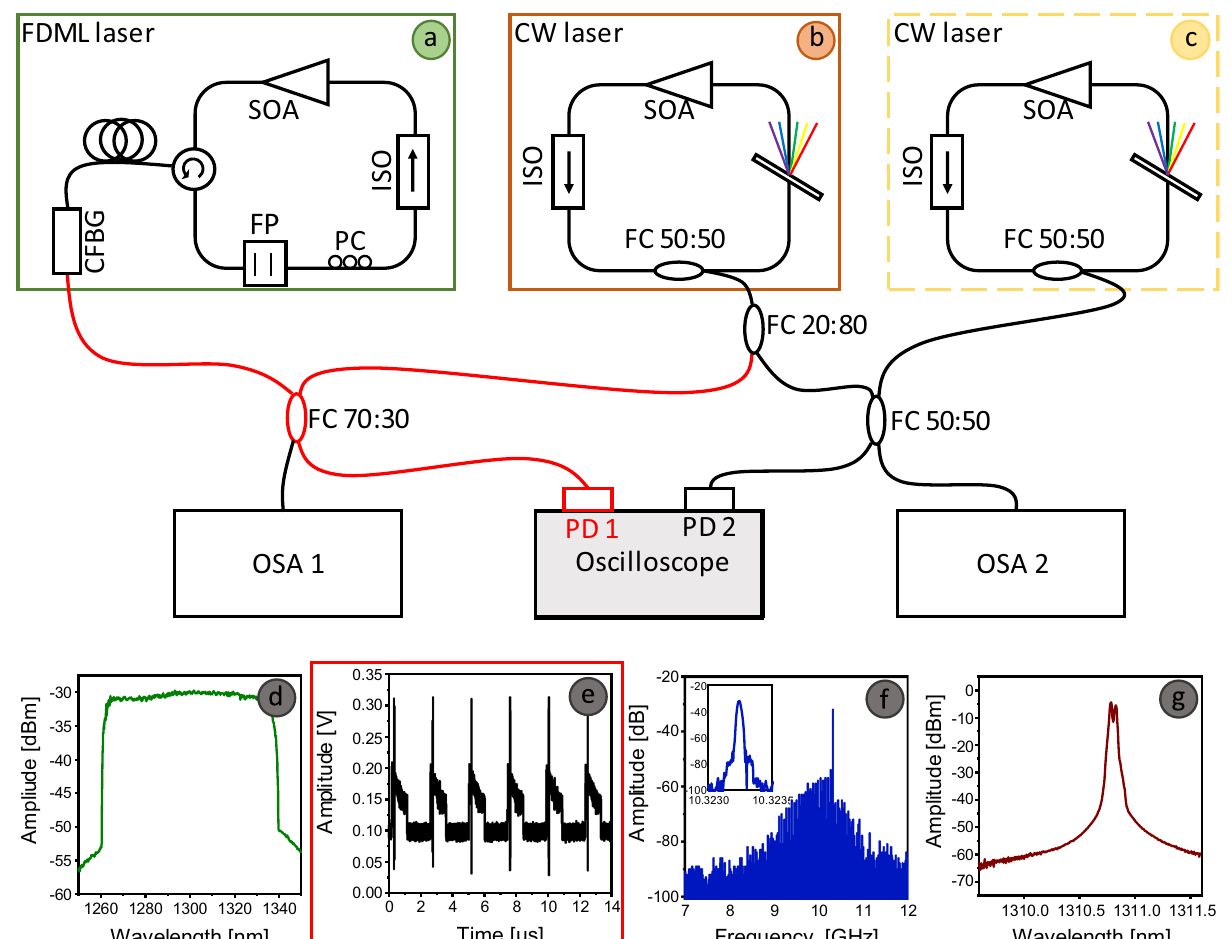
Fig. 1 Setup for beat signal measurements. The core of the investigation is the superposition of the temperature stabilized Fourier domain mode-locked (FDML) laser ( a ) and one continuous wave (CW) laser ( b ) as shown in red. An auxiliary CW laser ( c ) is superimposed with the fi rst one to simultaneously generate a second beat signal to monitor the short-term linewidth of the CW lasers. One optical spectrum analyser (OSA 1) is used to monitor the spectrum of the FDML laser ( d ). The transient beat signals between FDML laser and CW laser ( e ) are measured on a photodiode PD 1 and recorded with a fast real-time oscilloscope (shaded rectangle). The time trace of the second beat signal was measured on the second channel of the oscilloscope with a photodiode PD 2. A live Fourier transform was performed on the signal showing the radio frequency spectrum ( f ) to estimate an upper limit of the convoluted linewidth of both CW lasers. Only measurements for which this second monitoring signal shows a narrow linewidth were used for the analysis of the FDML laser, because only then we can assume that the CW laser had a suf fi ciently narrow linewidth to see fl uctuations on the FDMLlaser ’ s linewidth.For easytuning of the CWlasers to generate a certain desired beat frequency, their optical spectra ( g ) were detected with OSA 2. The optical spectrum of both CW lasers corresponds to the shown ~10.3 GHz beat note frequency. SOA = semiconductor optical ampli fi er, ISO = optical isolator, PC = polarization controller, FP = tunable Fabry-Pérot fi lter, CFBG = chirped fi bre Bragg grating, FC = fi bre coupler, PD = photodiode, OSA = optical spectrum